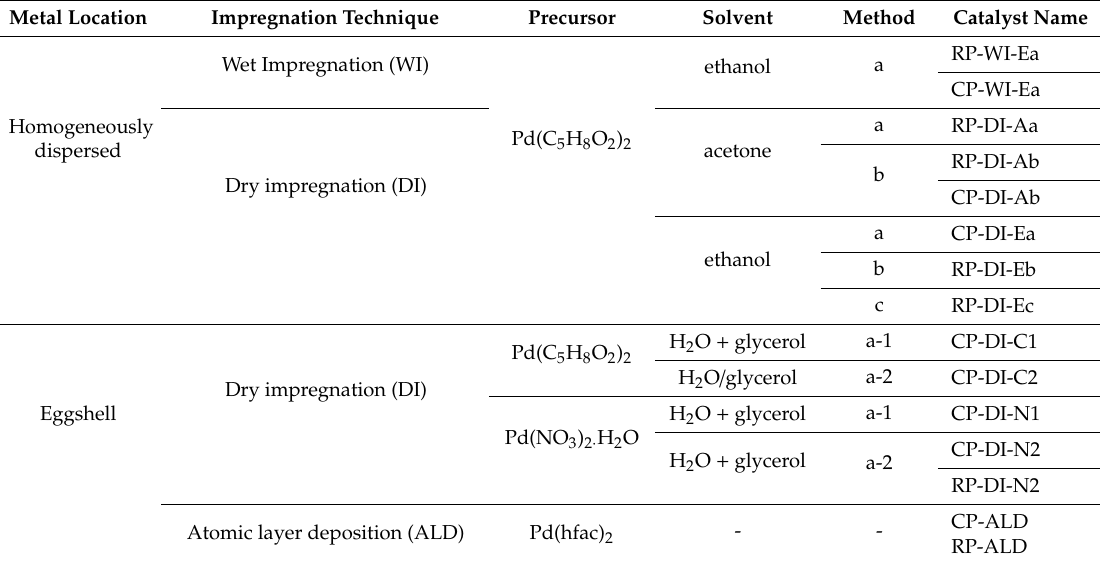
Table 3. Summary of the impregnation techniques studied and the catalyst